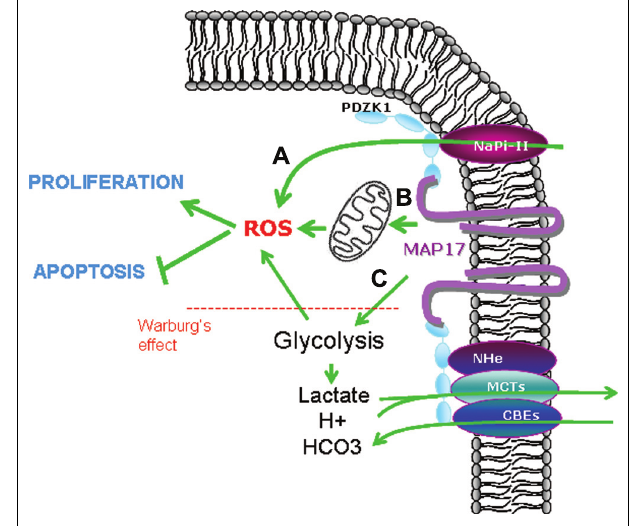
FIGURE 4 | Possible mechanisms involved in MAP17-dependent increase of ROS. (A) Direct pH alteration by membrane transports, (B) increase in glucose metabolism through mitochondrial respiration, (C) increase in aerobic glycolysis (Warburg’s effect) which is allowed by acidic detoxification carried out by membrane transports bund to MAP17–NHeRFs